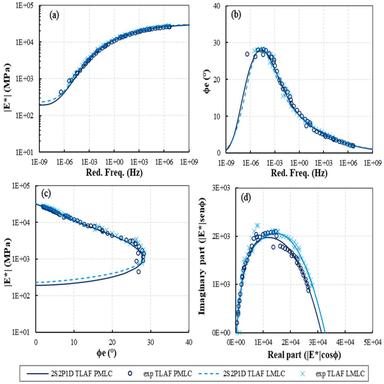
Stiffness of the "TLAF" asphalt mixture with LMLC and PMLC samples: (a) dynamic modulus master curve; (b) phase angle master curve; (c) Black space; (d) Cole-Cole.